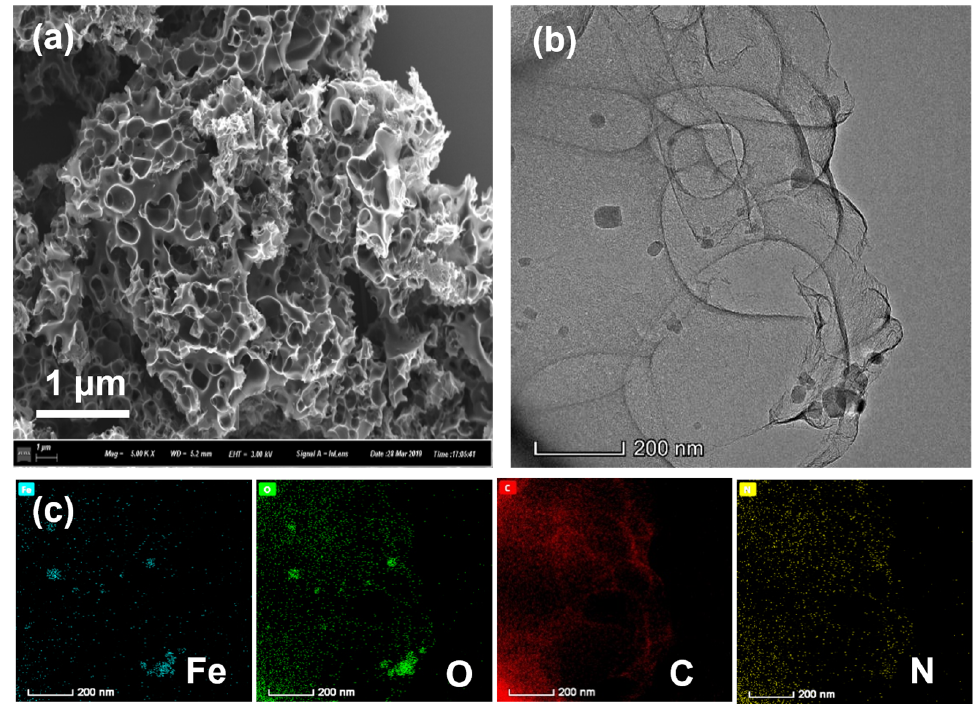
Figure 2. ( a ) The SEM images of Fe-PC@NaCl; ( b ) The TEM images of Fe-PC@NaCl; ( c ) the elemental mapping of the Fe-PC@NaCl catalyst.